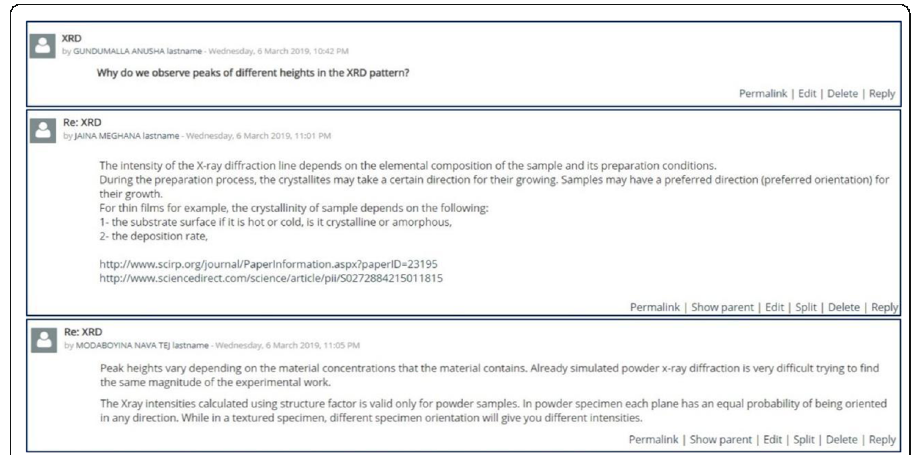
Fig. 4 Screenshot image of discussion forum (LxI) activity with a focus question for topic dealt